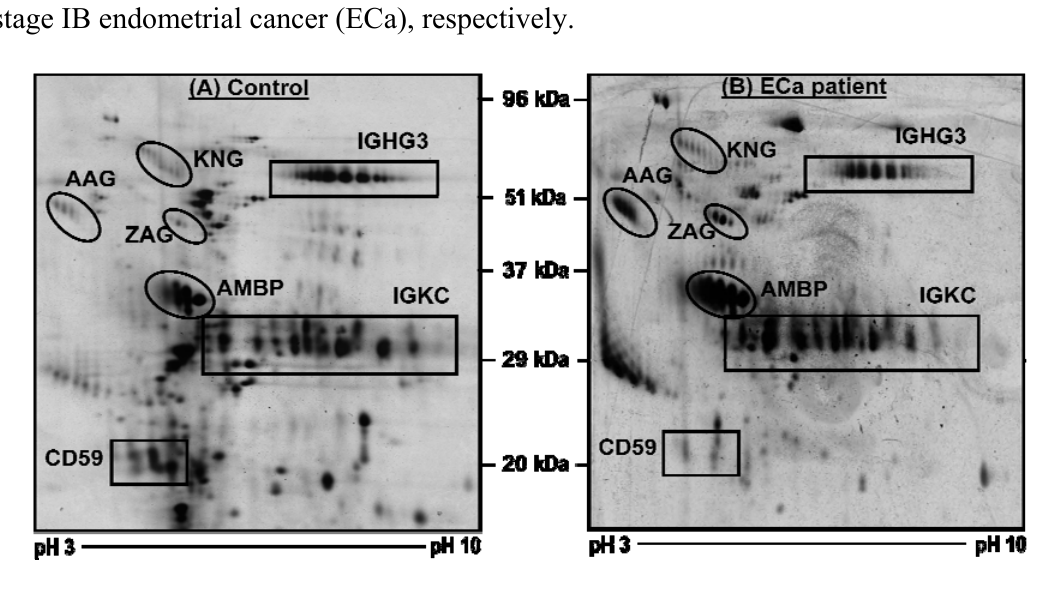
Table 1. Mass spectrometric identification of 2-DE separated urinary